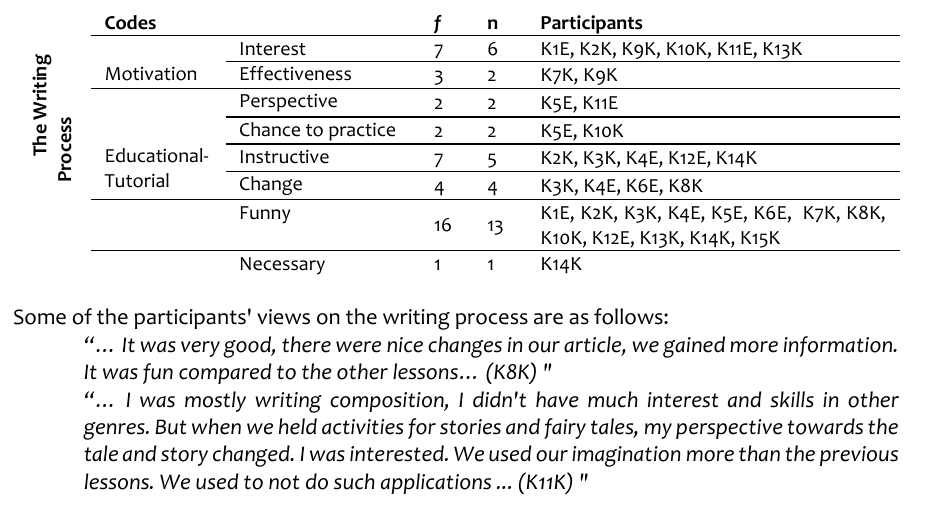
Table 4. Findings Regarding the Writing Process Theme